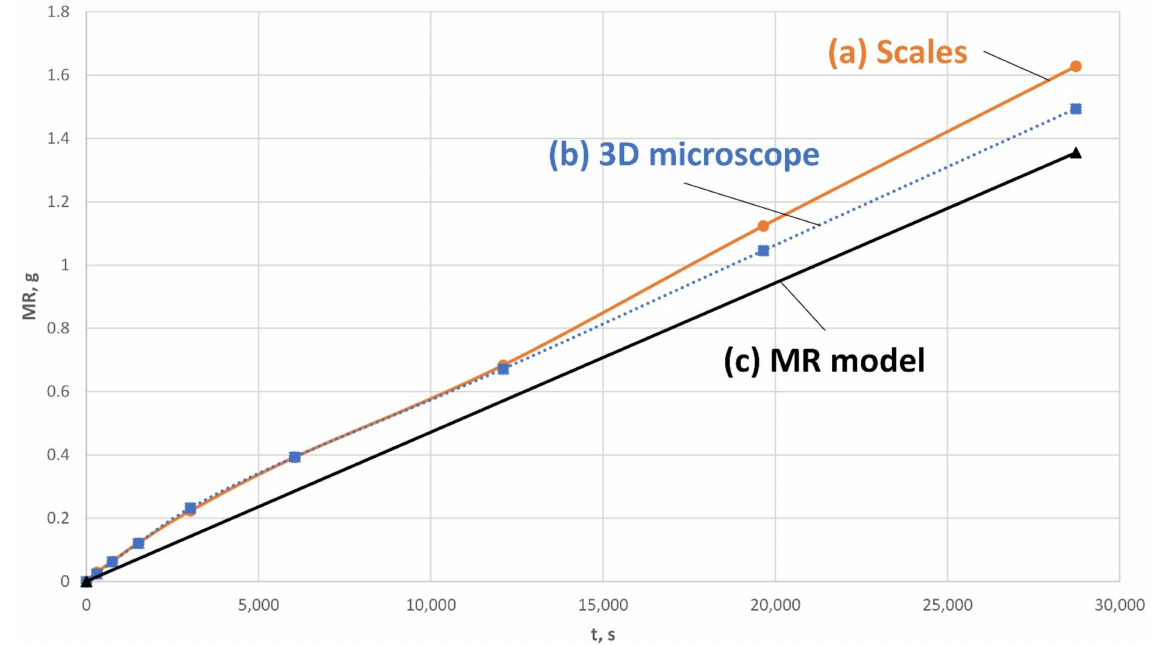
Figure 17. Pre-polished V-shape artifact: MR global measurements using ( a ) scales, ( b ) 3D microscope, ( c ) MR model (average values).